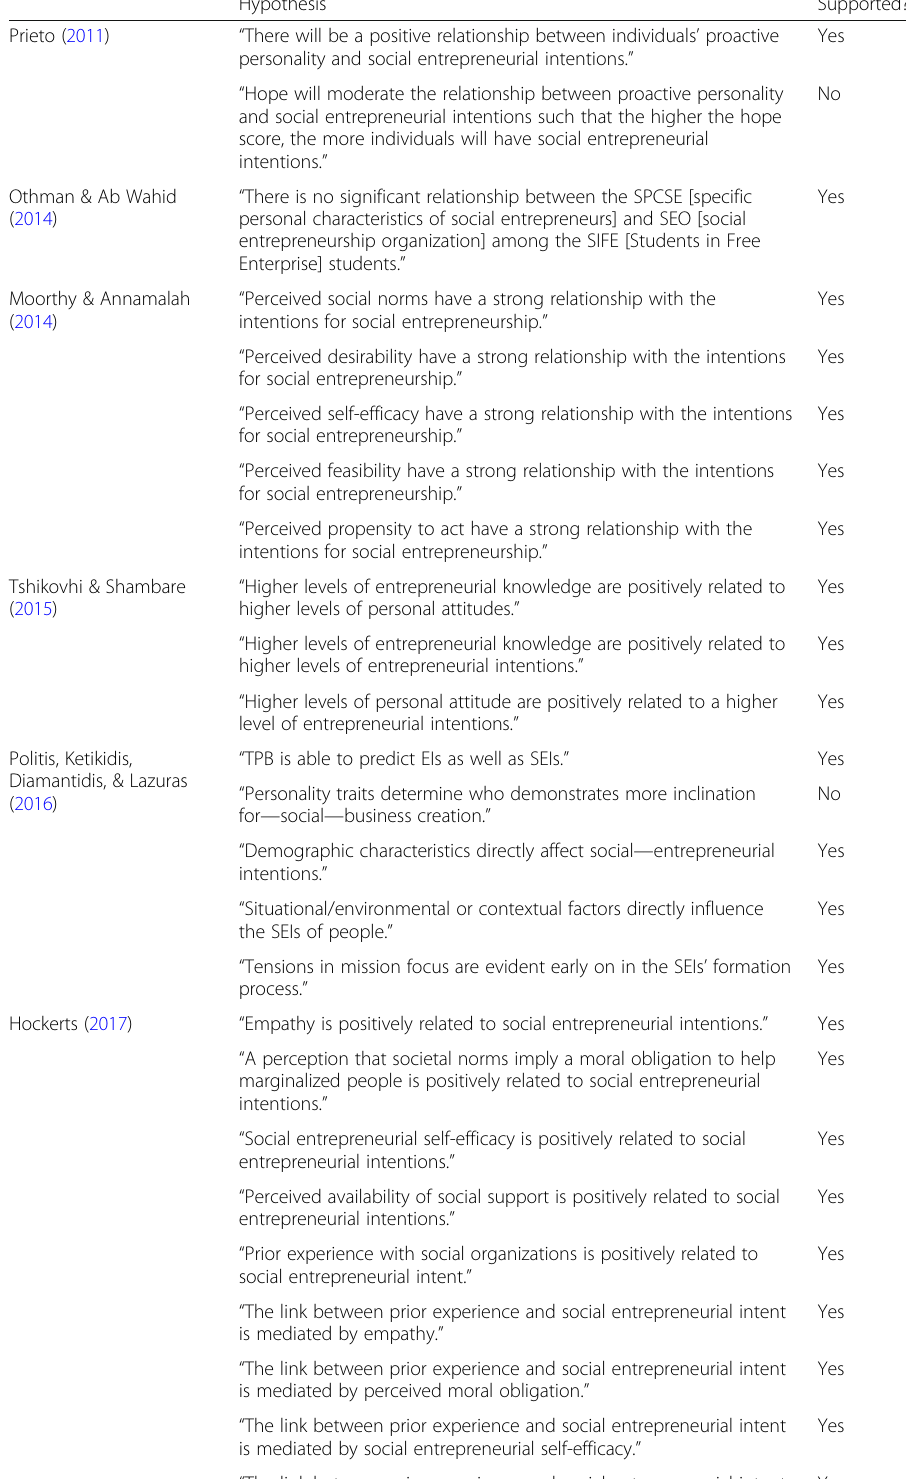
Table 2 Tabulated synthesis of results across different